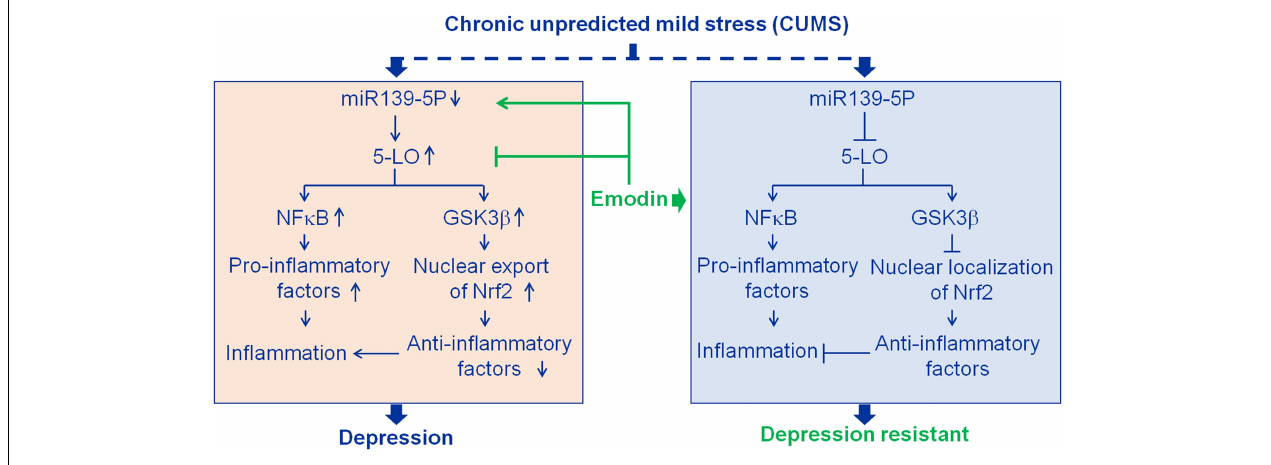
FIGURE 7 | Results summary diagram. Hippocampal inflammation plays an important role in depression. Emodin prevented chronic unpredicted mild stress (CUMS)-induced depression mainly by targeting miR139-5p/5-lipoxygenase (5-LO). Nuclear factor- κ B (NF- κ B) and glycogen synthase kinase 3 β (GSK3 β ) are the downstream factors of 5-LO. Nuclear factor erythroid 2-related factor 2 (Nrf2), a transcriptional activator of antioxidant genes, down-regulated by activated GSK3 β